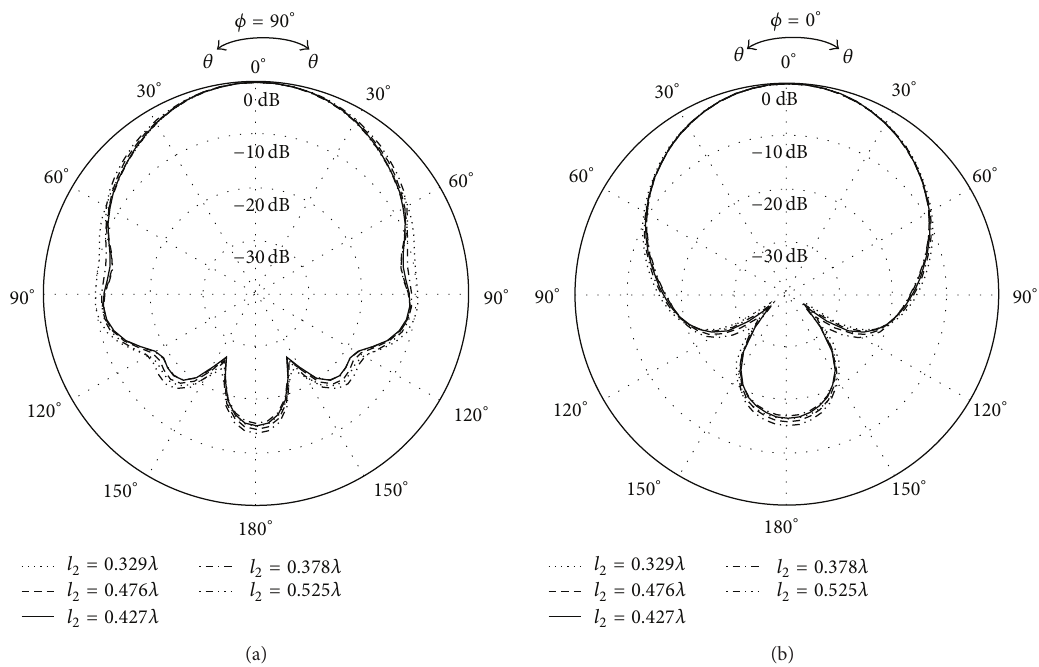
Figure 18: Simulated radiation patterns for various parasitic coupling aperture lengths ( 𝑙 2 ) at the lower frequency of 2.484 GHz in (a) the 𝐸 -plane and (b) the 𝐻